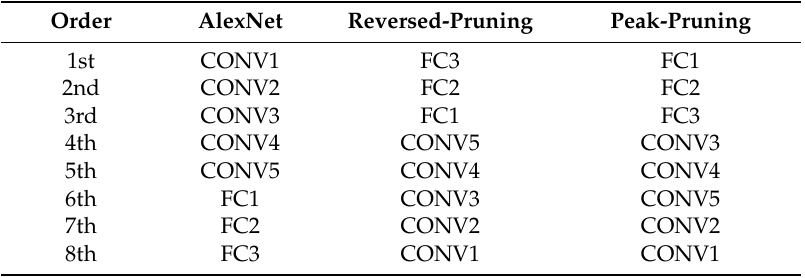
Table 1. The pruning order for reversed-pruning and peak-pruning of AlexNet.